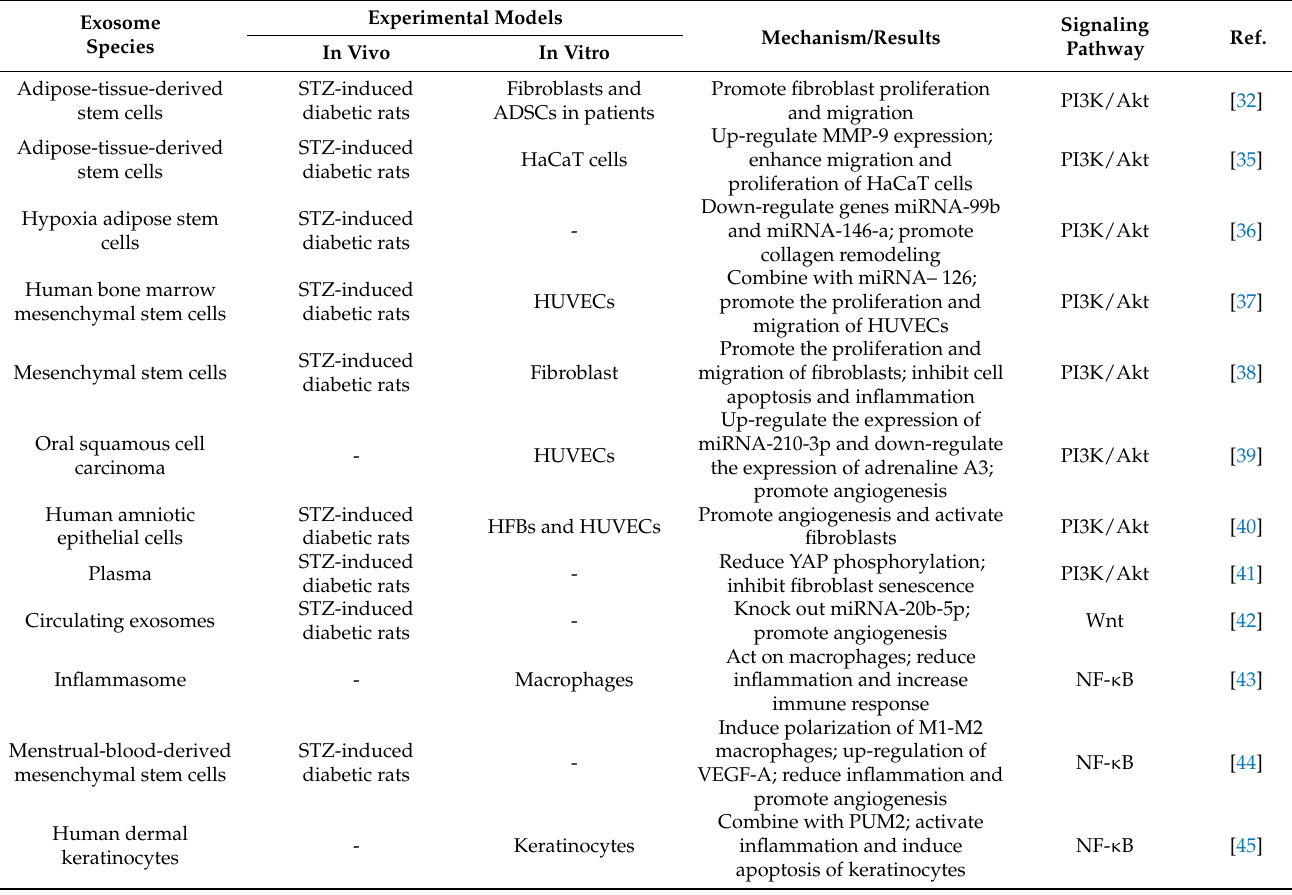
Table 1. The effects of various exosomes on diabetic wound healing via different signaling pathways. Experimental Exosome Species